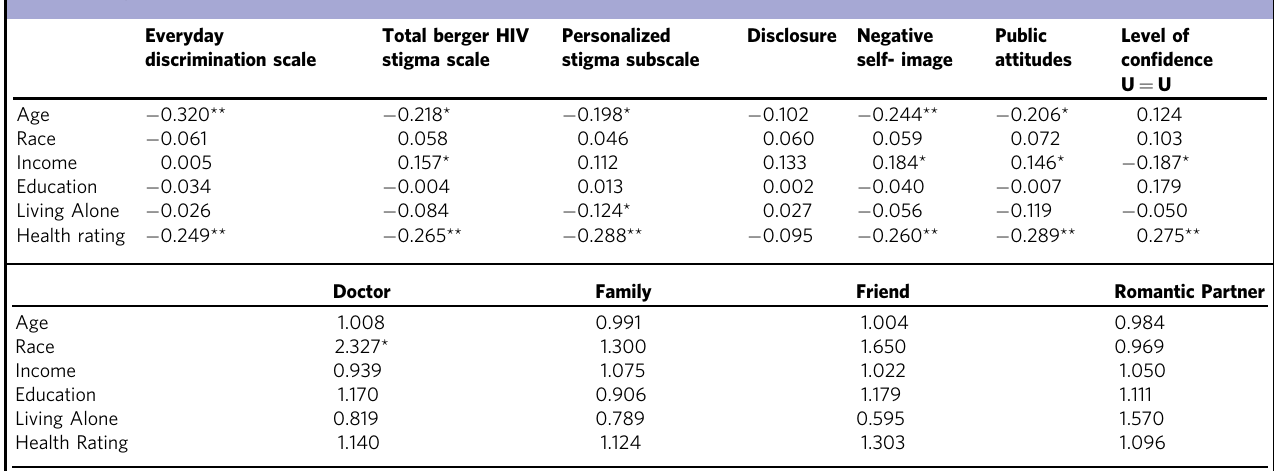
Table 2 Regression (standardized coef fi